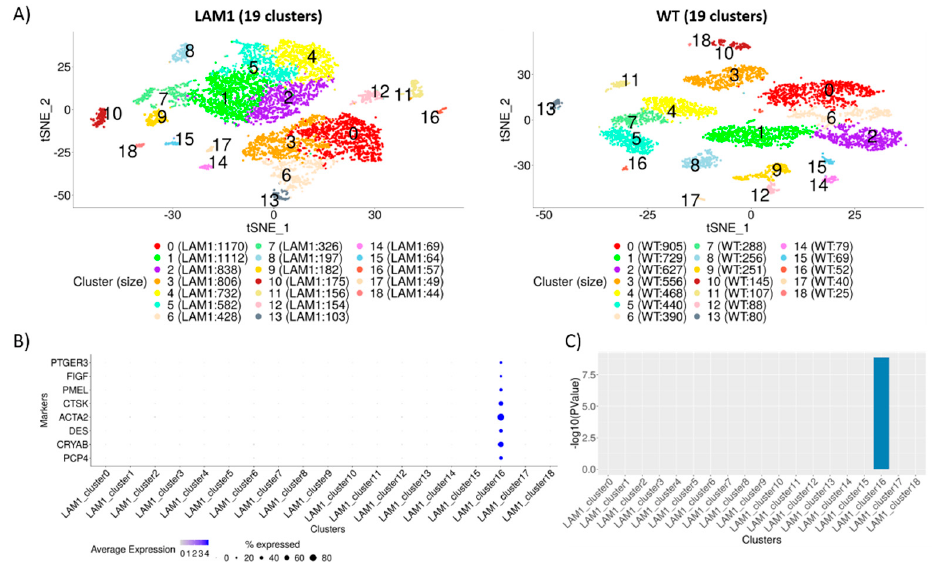
Figure 1. Cluster analysis of scRNA-seq samples. ( A ) Unsupervised clustering of 7244 cells from LAM1 (top panel) and 5595 cells from wild-type (WT) sample (bottom panel) is represented in two-dimensional t-SNE plots with perplexity 30. A total of 19 clusters were identified in each sample using Seurat’s graph-based clustering initialized with top principal components with largest variances. Clusters are colored and labeled distinctively, and the number of cells in each cluster is noted inside the parenthesis in the legends. ( B ) Expression of known LAM markers was used to identify the cluster of LAM cells, with the size of the dot representing the percentage of cells expressed, and color is proportional to the average expression of the genes. All the 8 markers show moderate to high expression in at least 30% cells in cluster 16 of LAM1. ( C ) Marker enrichment was conducted using Fisher’s exact test based on the significantly (FDR < 0.05) differentially expressed genes from each of the cluster annotating signatures of LAM1. All the markers were significantly DE only in cluster 16, whereas none of the markers were significant in any other cluster.